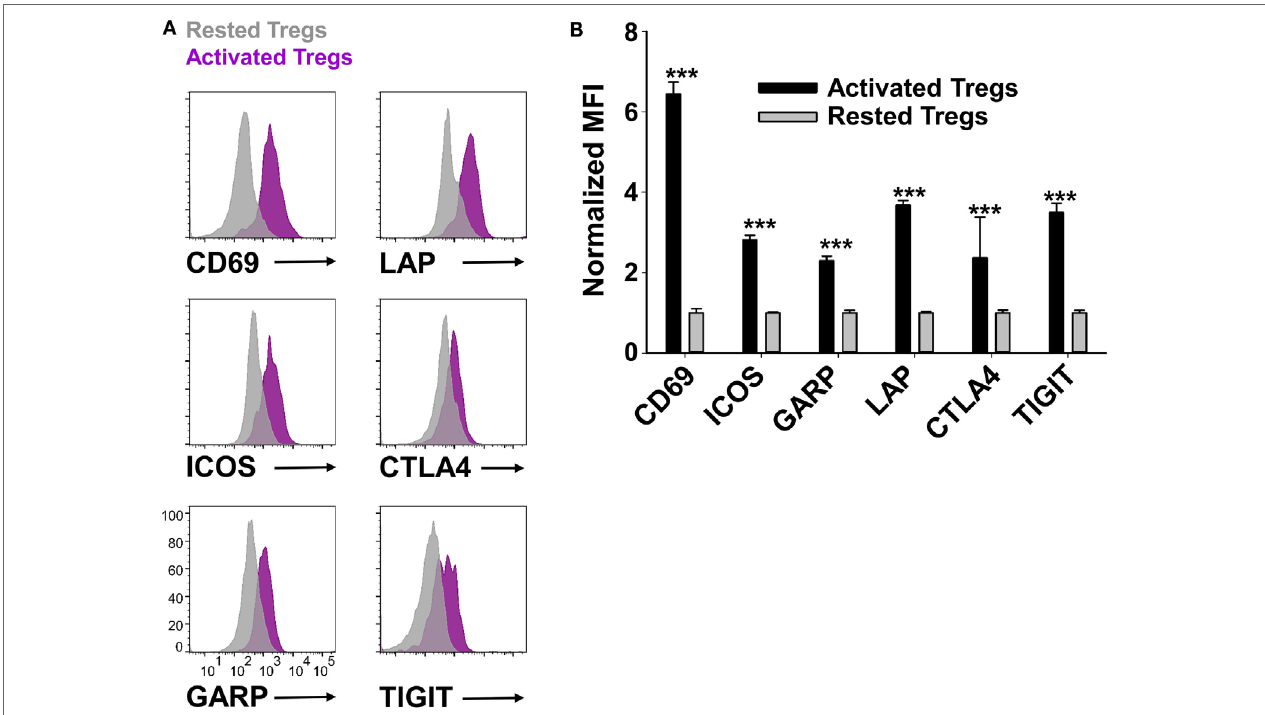
FigUre 9 | Reactivated regulatory T cells (Tregs) upregulated Treg-associated activation markers. To generate activated Tregs, 100,000 rested Tregs ( > 90% FOXP3 + ) and 10 6 irradiated splenocytes were cultured for 2 days with 1 µM MOG35-55, rat IL-2, and 10 µg/ml PC61. A control rested Treg line was passaged in IL-2 and PC61. Activated Tregs versus rested FOXP3 + Tregs were gated and analyzed for the indicated markers. Representative overlapping histograms are shown in panel (a) . Relative MFIs for the indicated markers on gated Tregs are shown in panel (B) . MFI values were normalized so that rested Treg MFI values were equal to 1. *** p < 0.001. These data are representative of three independent